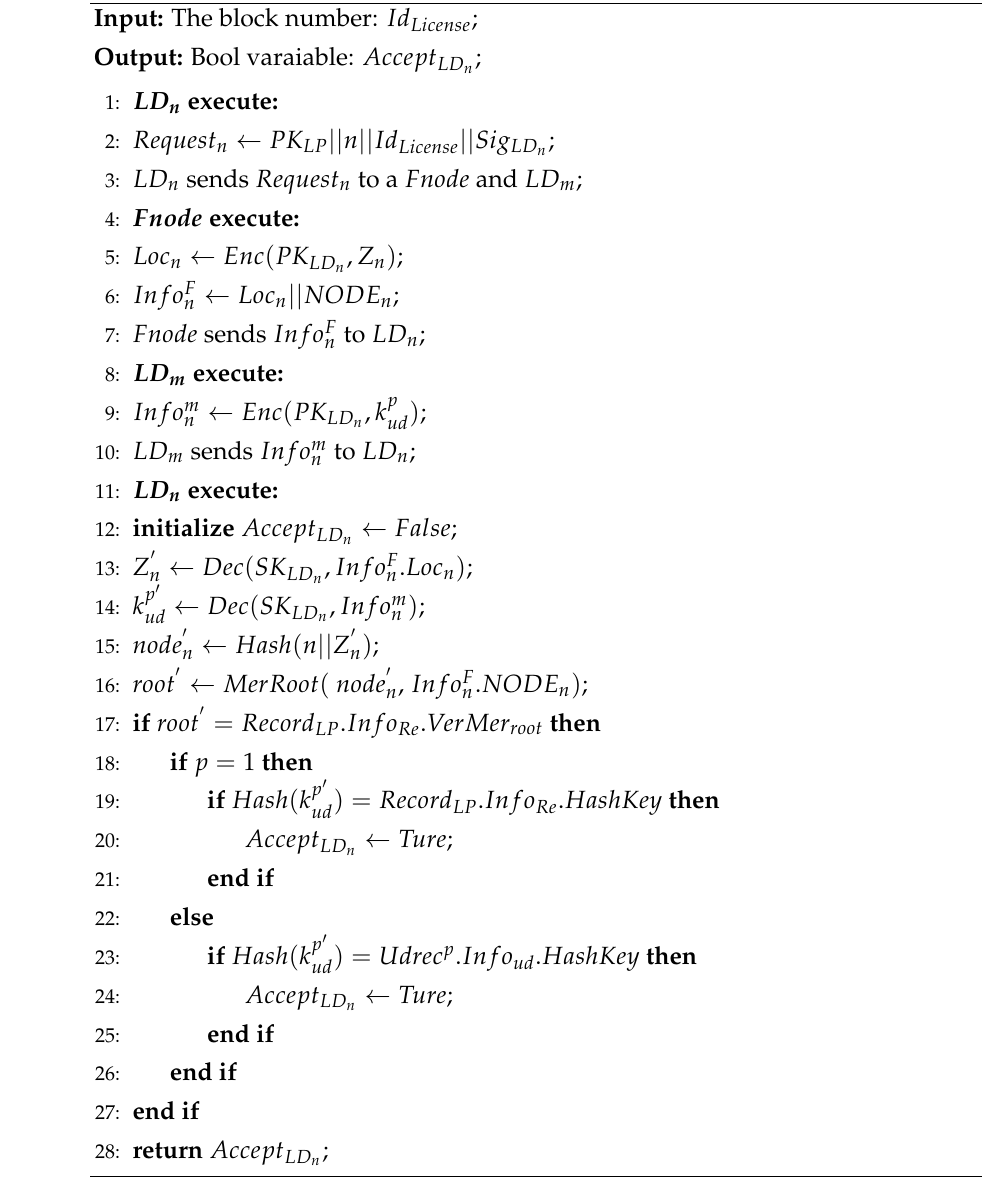
Algorithm 4 Location sharing: pseudocode for data-sharing and